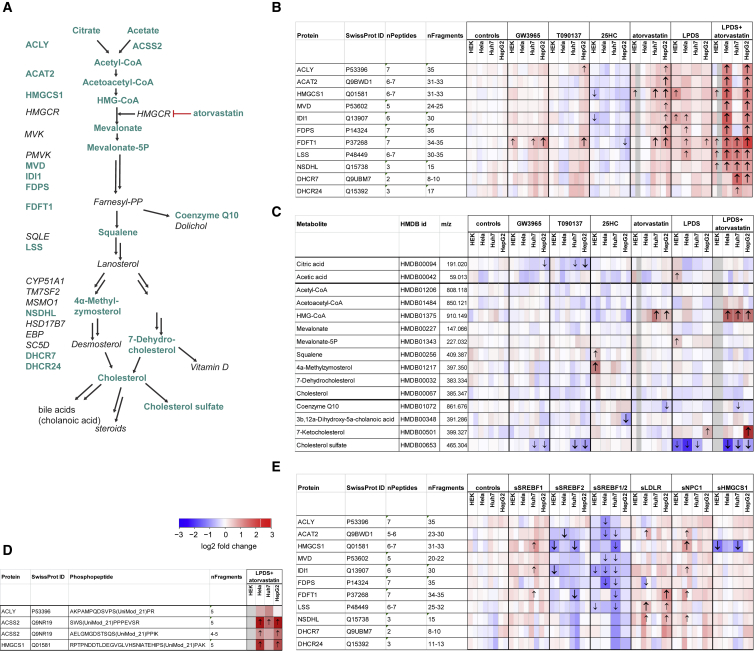
Quantitative Data for the Cholesterol Synthesis Pathway(A) Cholesterol synthesis pathway with quantified proteins and metabolites labeled in color.(B) Heatmap showing the difference in expression for the cholesterol synthesis enzymes.(C) Heatmap showing the difference in abundance of the metabolites from the cholesterol synthesis pathway.(D) Heatmap showing the difference in abundance of phosphopeptides after LPDS + 1 μM atorvastatin treatment. One of the probable localization of the HMGCS1 phosphorylation site is shown (see also Table S3 and Figure S3).(E) Heatmap showing difference in expression of the cholesterol synthesis enzymes after treatment with siRNAs.(B–E) Arrows indicate the direction of the statistically significant change in expression: (B and E) n = 3; |log2FC| > 0.5 and FDR < 0.001; (C and D) n = 3; |log2FC| > 0.5 and FDR < 0.01. For further details, see the STAR Methods.